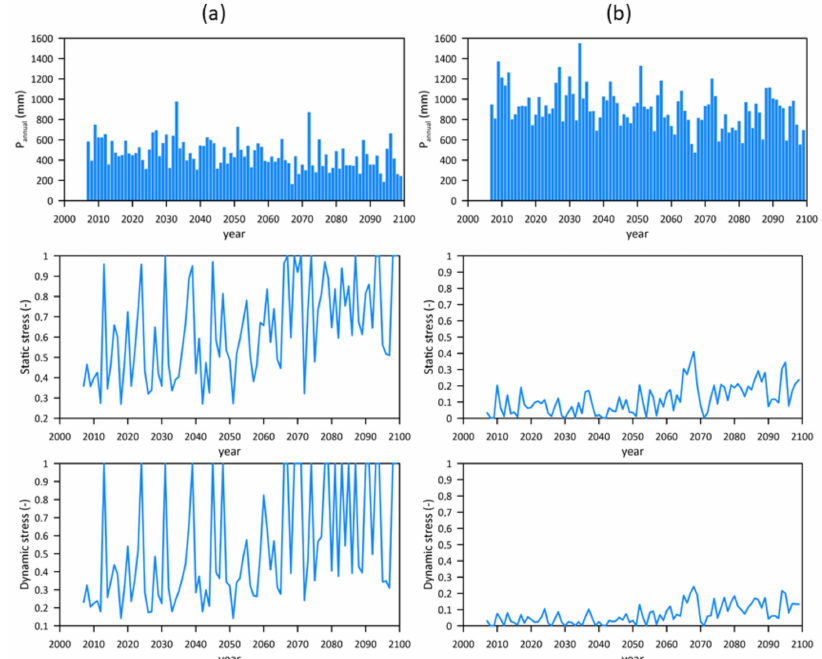
Figure 2. Evolution of precipitation, static stress and dynamic stress between 2006–2100, for a site in southern Spain and northern Spain, respectively: ( a ) site La Rambla, C ó rdoba (N 37.606, W − 4.741); ( b ) Lugo, Lugo (N 43.011, W − 7.555).